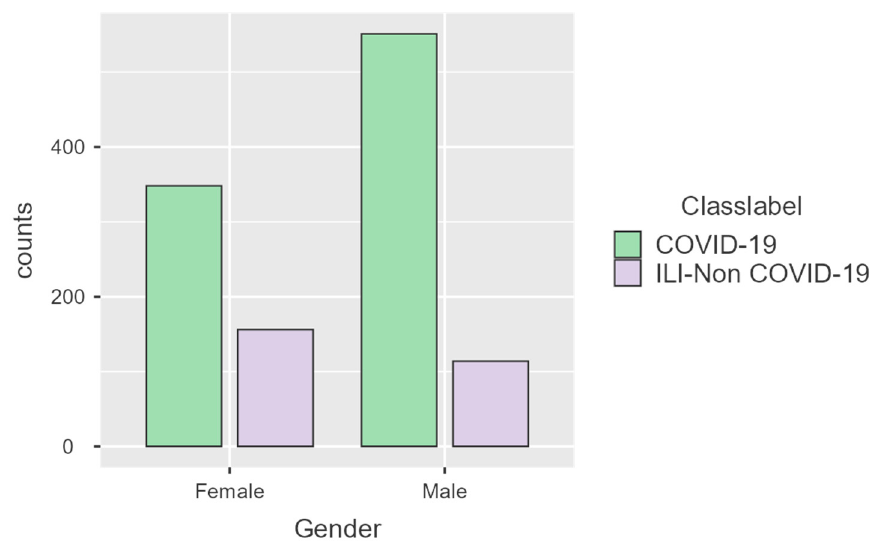
Figure 3. Bar graph depicting male and female population present in the dataset. (0—non-COVID-19 ILI patients, 1—COVID-19 patients).